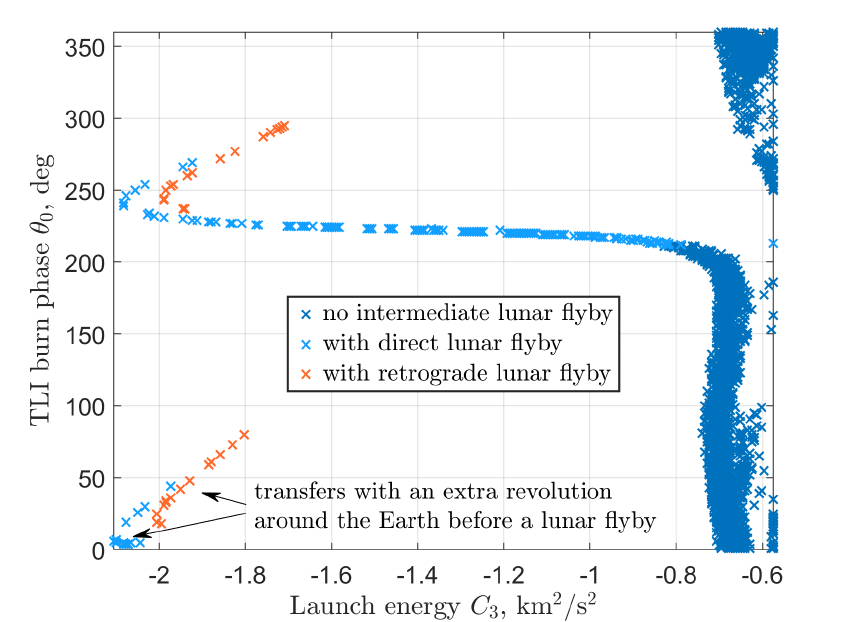
Figure 15. Initial conditions (the launch energy C 3 and the TLI burn phase) corresponding to the three types of SALT trajectories: without an intermediate flyby (blue), with a direct lunar flyby (light blue), or with a retrograde lunar flyby (red).